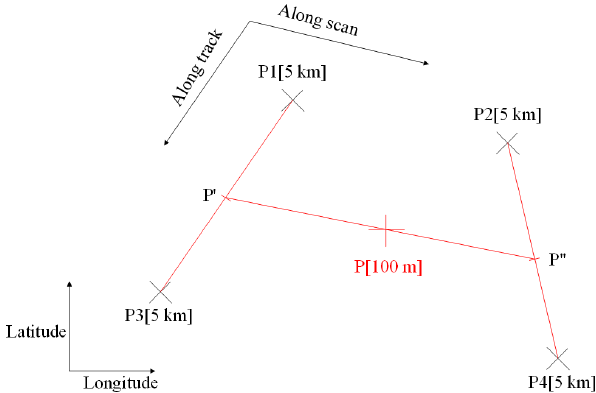
Figure 3. The process used to generate a fine-resolution geolocation